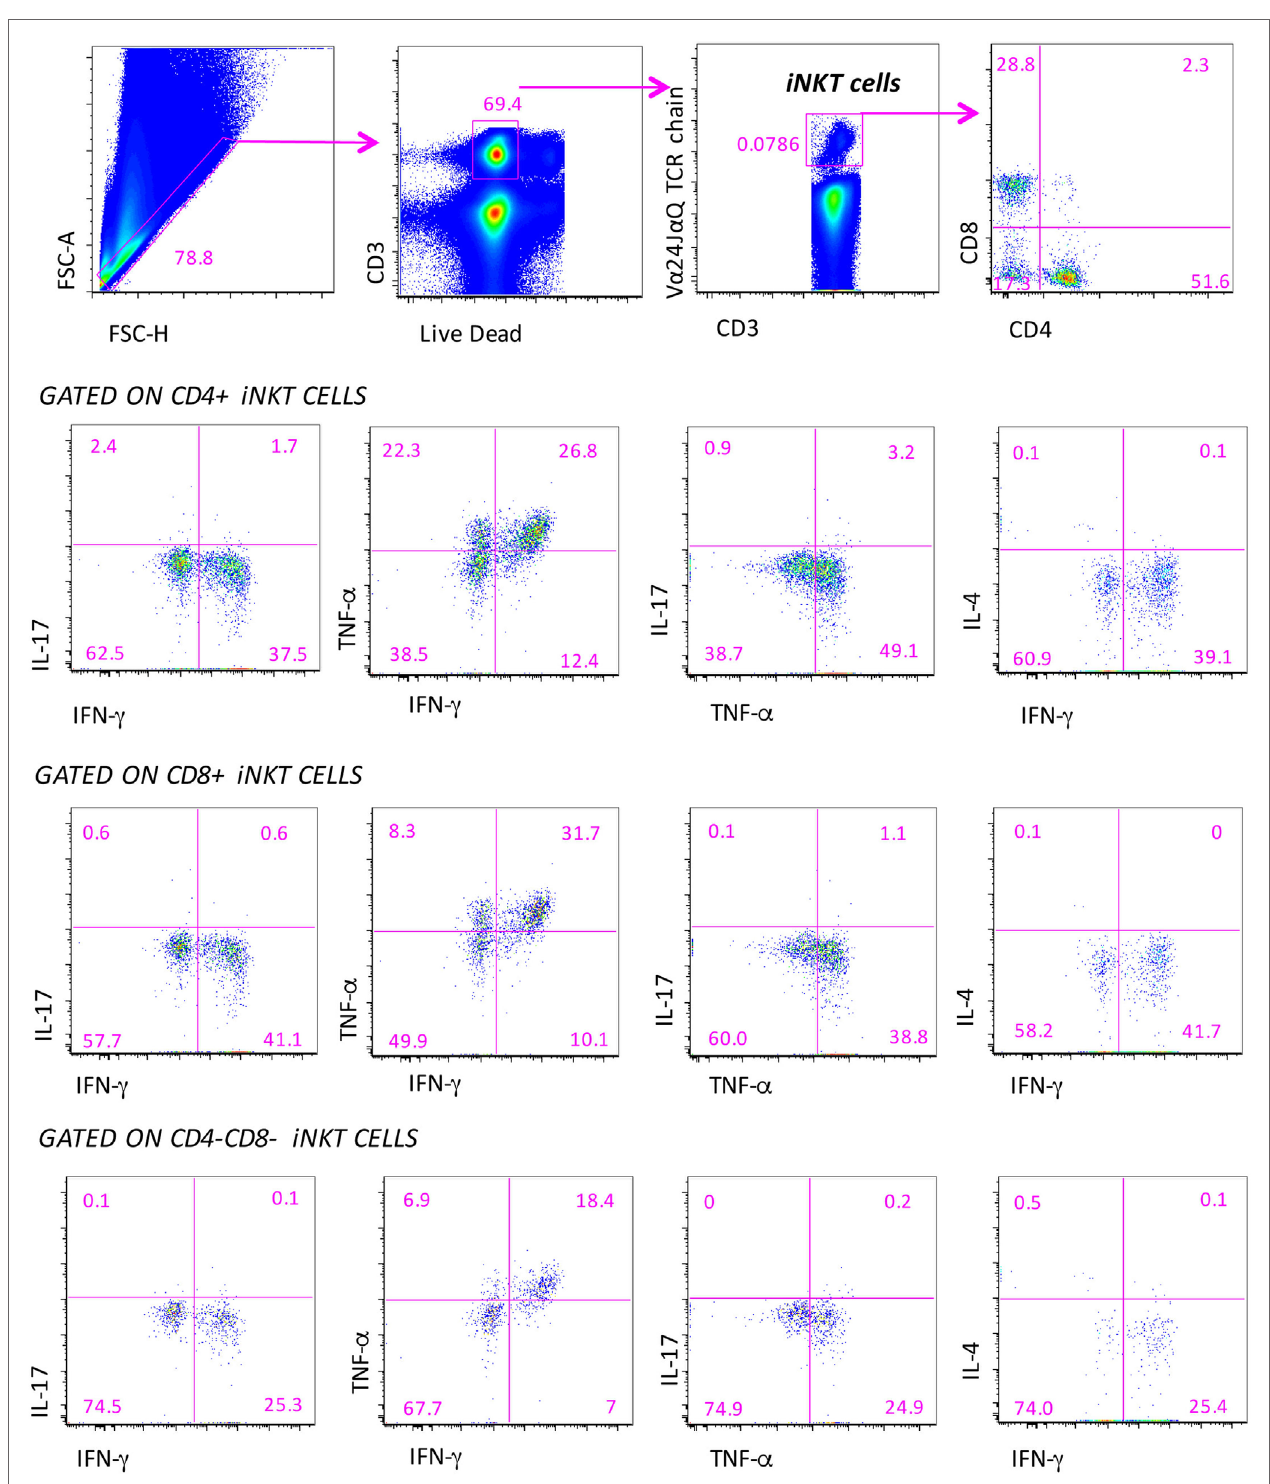
FigUre 3 | gating strategy for the identification of the polyfunctionality of different subpopulations of inKT cells . Several electronic gates were set, first to exclude doublets on the basis of physical parameters (forward scatter area and height), then to exclude dead cells and to identify CD3 + T lymphocytes, and finally to recognize iNKT cells and their subpopulations, on the basis of CD4 and CD8 expression. Among these subpopulations, the production of IL-4, IL-17, TNF- α , and IFN- γ is quantified. Nine-color flow cytometry was used, acquiring a minimum of 10 million events per sample.